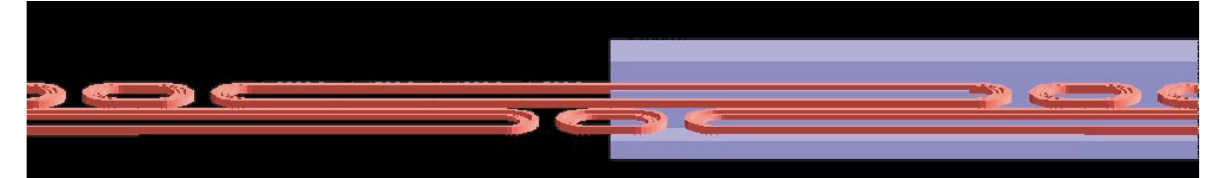
FIG. 24. (Color) Three-dimensional view of the storage ring